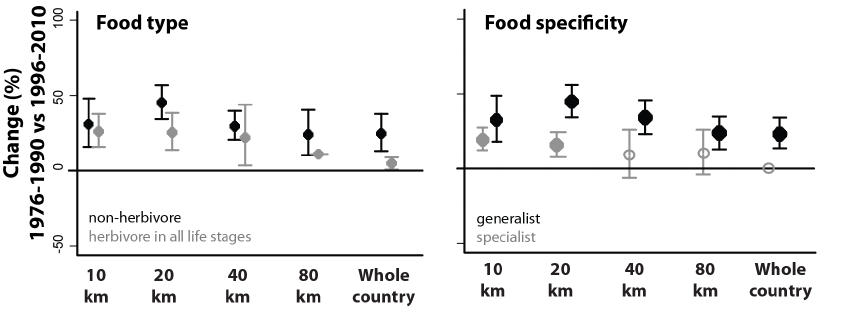
Figure 4. Trends in species richness change ( D S% + 2 95% confidence intervals) for the food trait-based subsets of Orthoptera species. Trends at the 10, 20, 40, 80 km grids and whole country. See table S3 of the supporting material for the numbers of grid cells. Filled symbols indicate change of significantly diffrent from zero; open symbols indicate that change was not significantly different from zero. A pair of results is considered not to be significantly different if the error bars do not overlap.